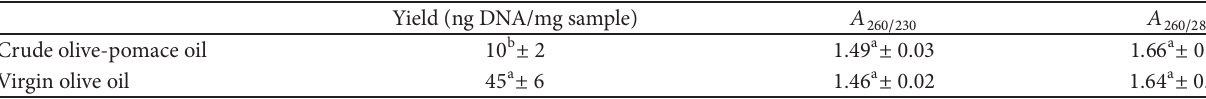
Table 1: DNA extraction yield and spectrophotometric absorption ratios of crude olive-pomace oil and the corresponding virgin olive oil (mean and standard deviations; n = 6; i.e., 2 replicated oil production trials and 3 independent DNA extractions each). Different superscript letters in the same column indicate significant differences at p < 0.05.